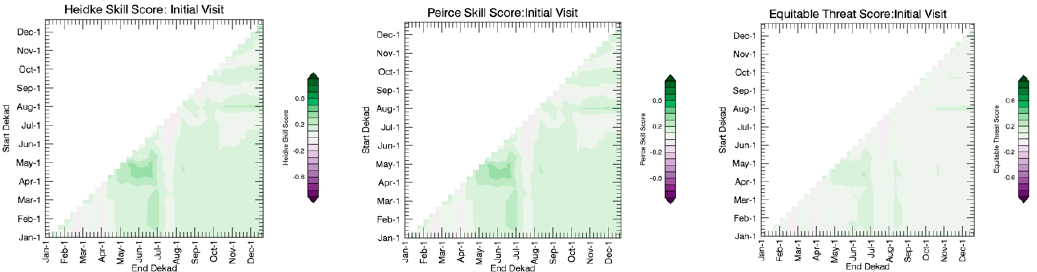
Figure 2. Histogram of farmer-reported “bad years” for 21 villages in Tigray; initial visit.